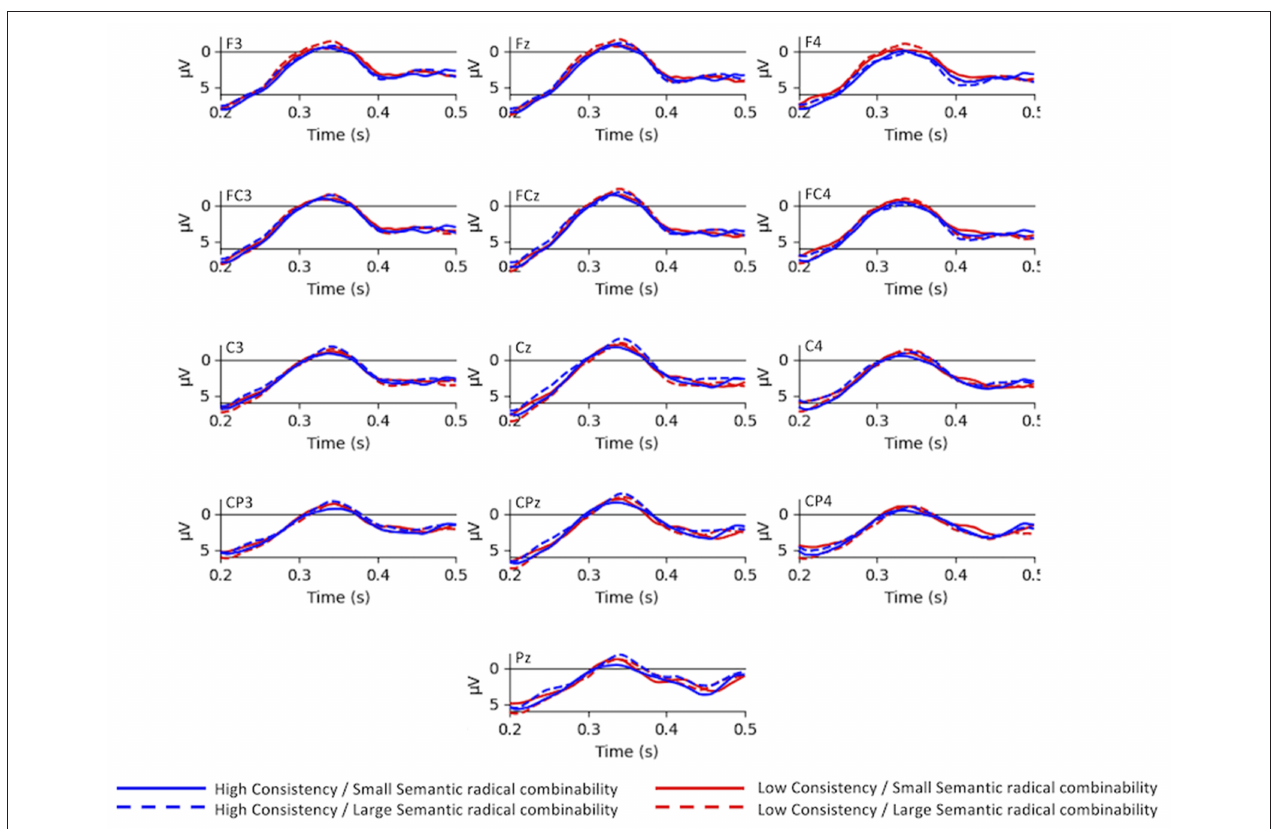
FIGURE 6 | The grand-average waves of